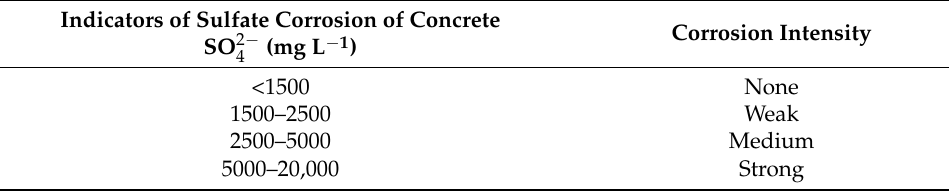
Figure 4. Sulfate concentrations in the 9 investigation boreholes. Table 1. Evaluation criteria of sulfate corrosion of concrete.